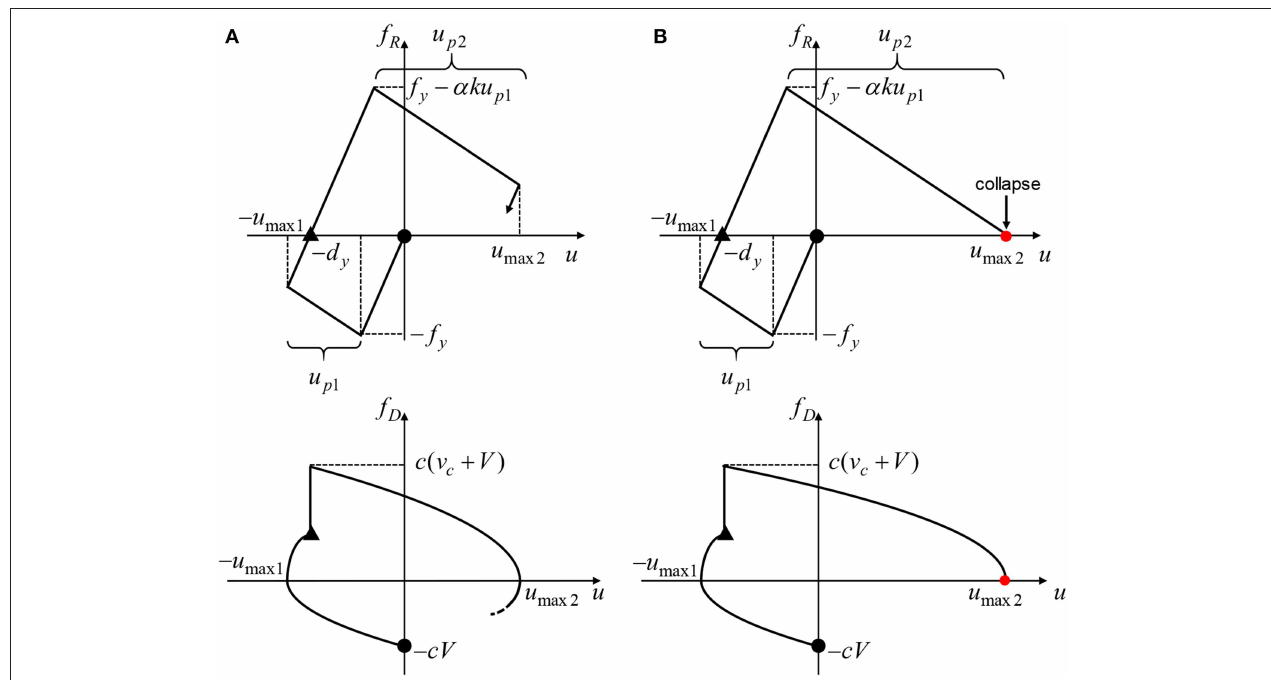
FIGURE 2 | Restoring force-deformation relation and damping force-deformation relation of damped bilinear hysteretic SDOF system with negative post-yield stiffness under critical double impulse, (A) Stable state, (B) Collapse state (•: First impulse, N : Second impulse).